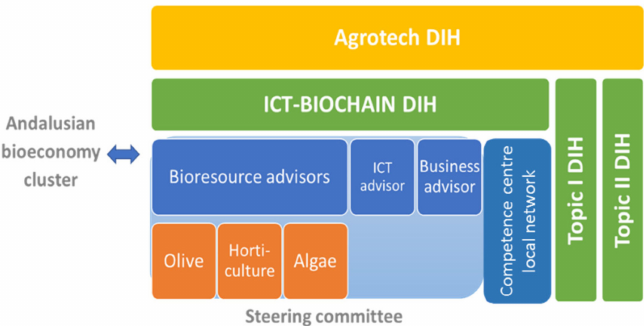
Figure 6. Andalusian DIH structure and how it integrates with the already existing Agrotech